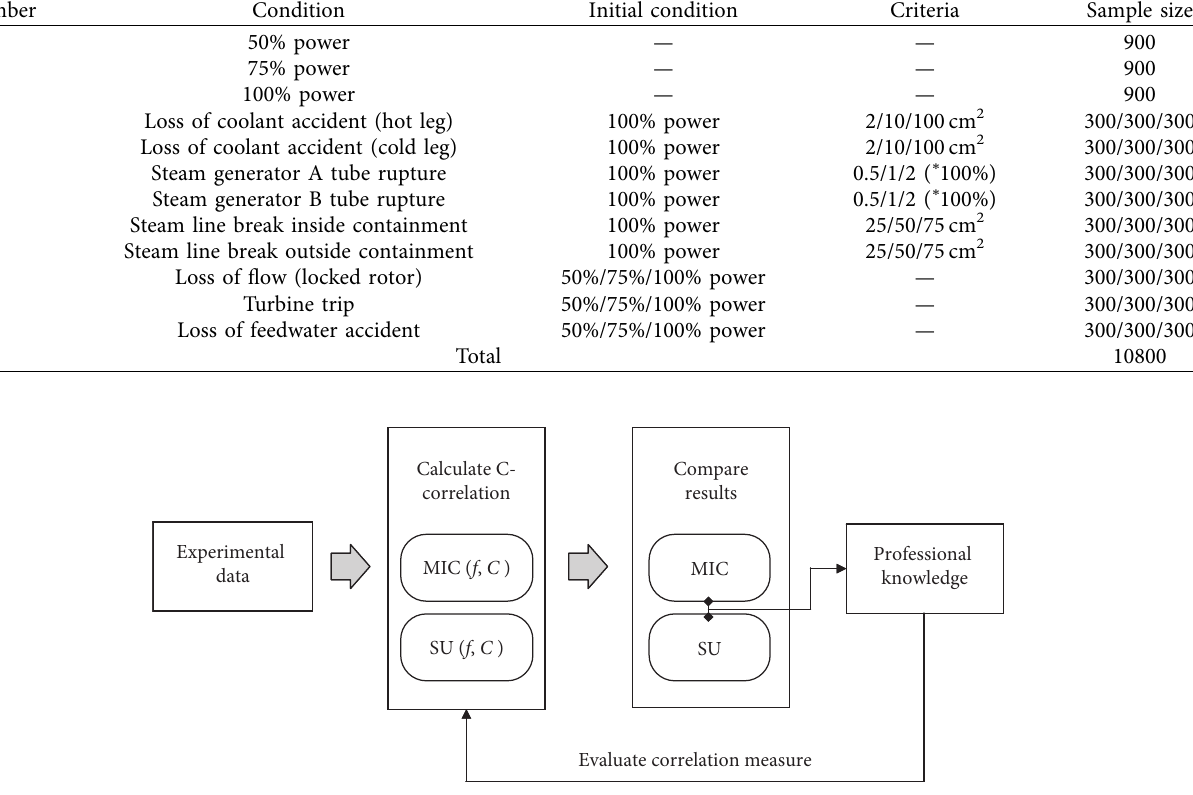
Figure 3: Program of correlation measure verification experiment. Table 2: Correlation measure verification experiment